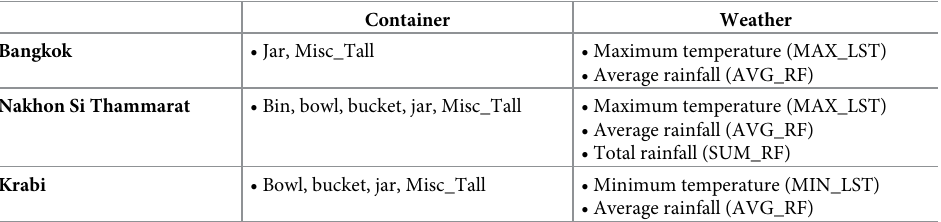
Table 2. List of variables for each